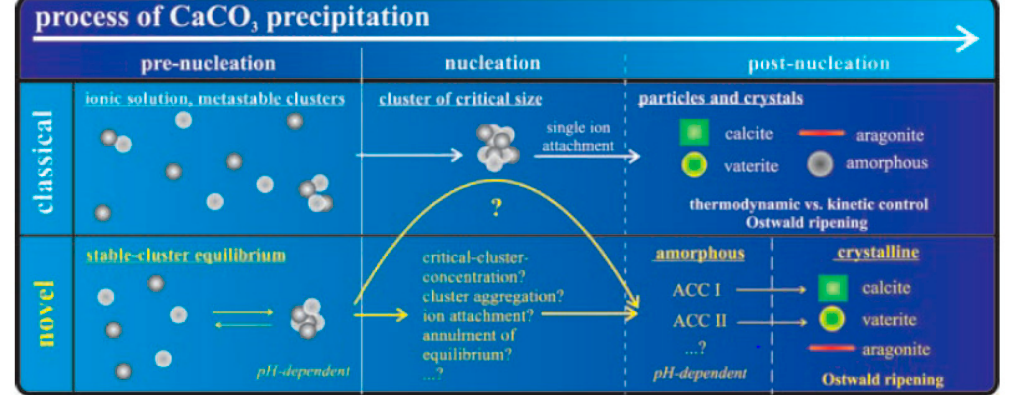
Figure 3. Calcium carbonate precipitation mechanism [51]. With permit of the copyright (Copyright Clearance Center License 4635610839441).